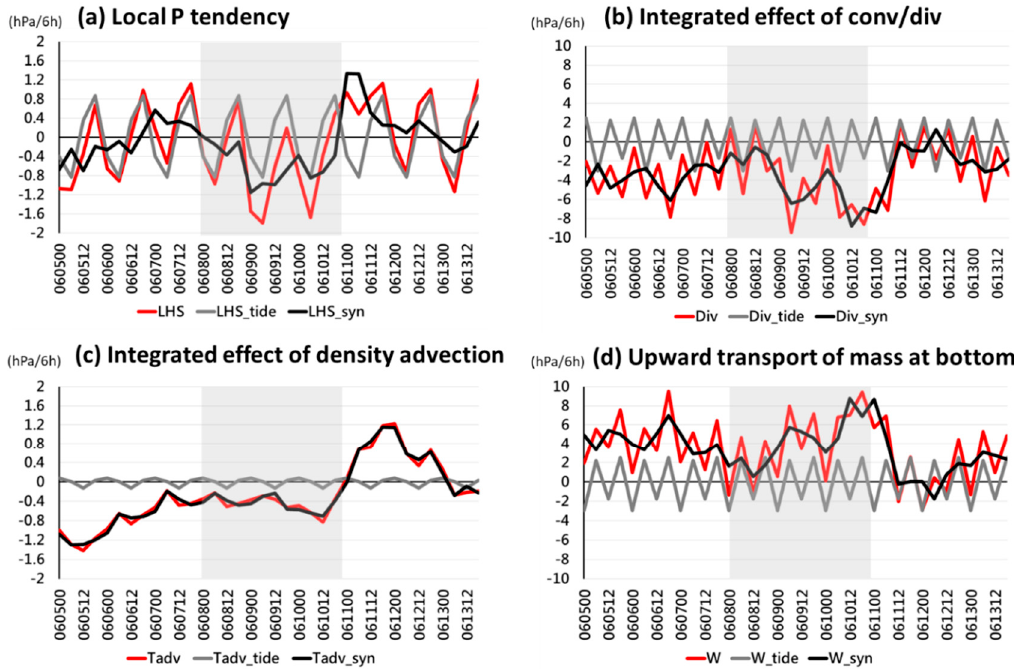
Figure 10. ( a ) The low-level pressure tendency in South China (computed for the red box in Figure 1), and its three forcing terms of ( b ) column-integrated convergence/divergence, ( c ) column-integrated density (thermal) advection, and ( d ) mass transport by vertical motion (all in hPa per 6 h), from 0000 UTC 5 to 1800 UTC 13 June 2012. For each term, the original time series (red), its diurnal (or semi-diurnal) component (gray), and the synoptic signals (black, = red minus gray) are shown. The time in the horizontal axis is given in the format of “mmddtt” for month, date, and time (h in UTC).